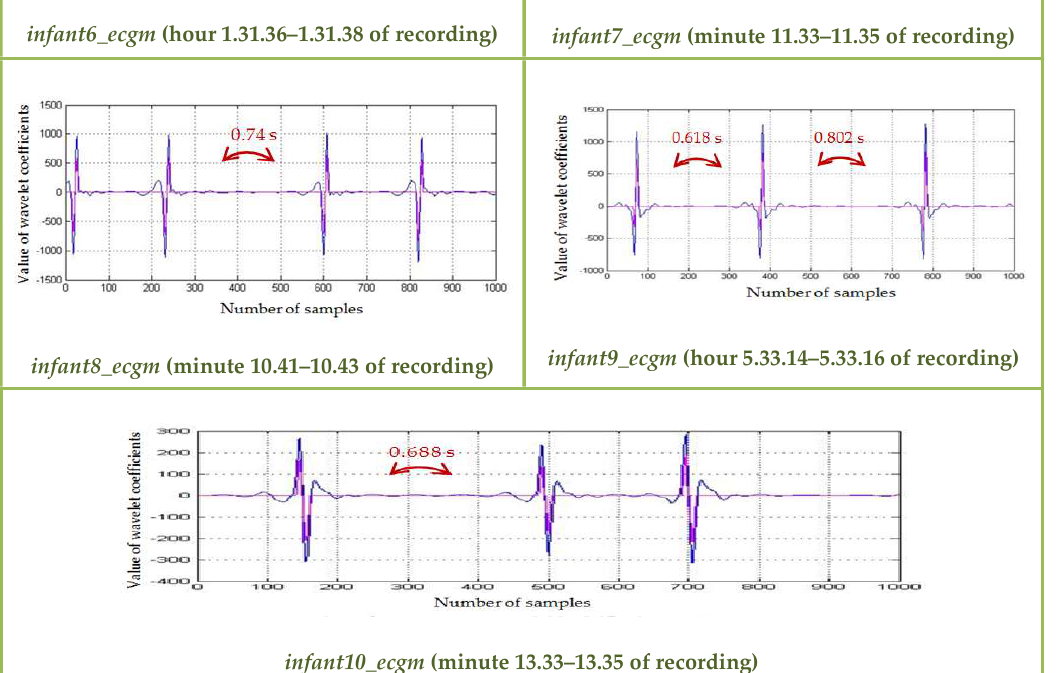
Figure 8. Zoom on the detected R-peak values on bradycardia events for preterm infants of the PhysioNet database, db8 MW, 1000 samples.